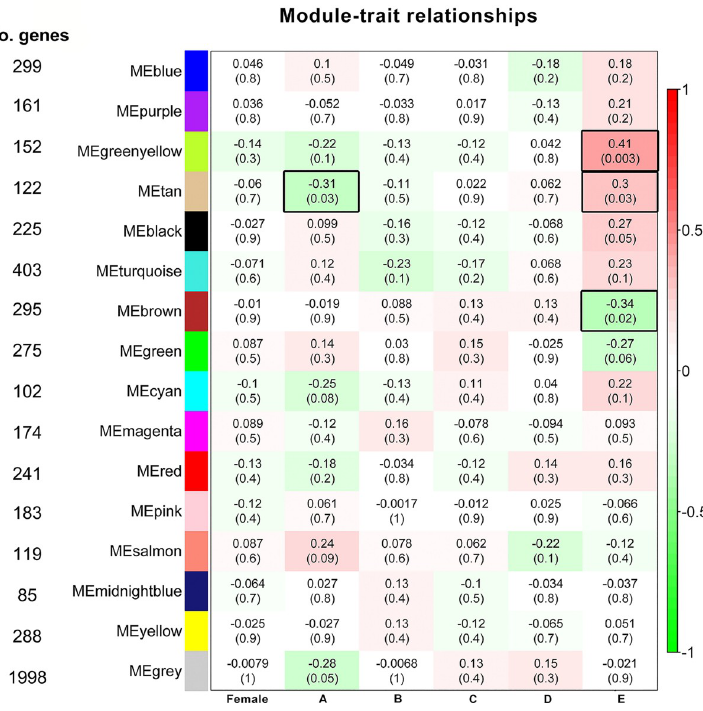
Fig 2. Module-trait relationships. WGCNA module significance (MS) correlations with gender and age groups. In the rows, module eigengenes (MEs) named by their module colors. In the columns, the traits of interest. Numbers inside each colored box are the correlation coefficients between the ME and the specific trait, with p-value in parentheses. The more intense the box color, the more negatively (green) or positively (red) correlated is the module with the trait (MS, as indicated by color bar). Black-border boxes highlight the significant module-trait relationships.